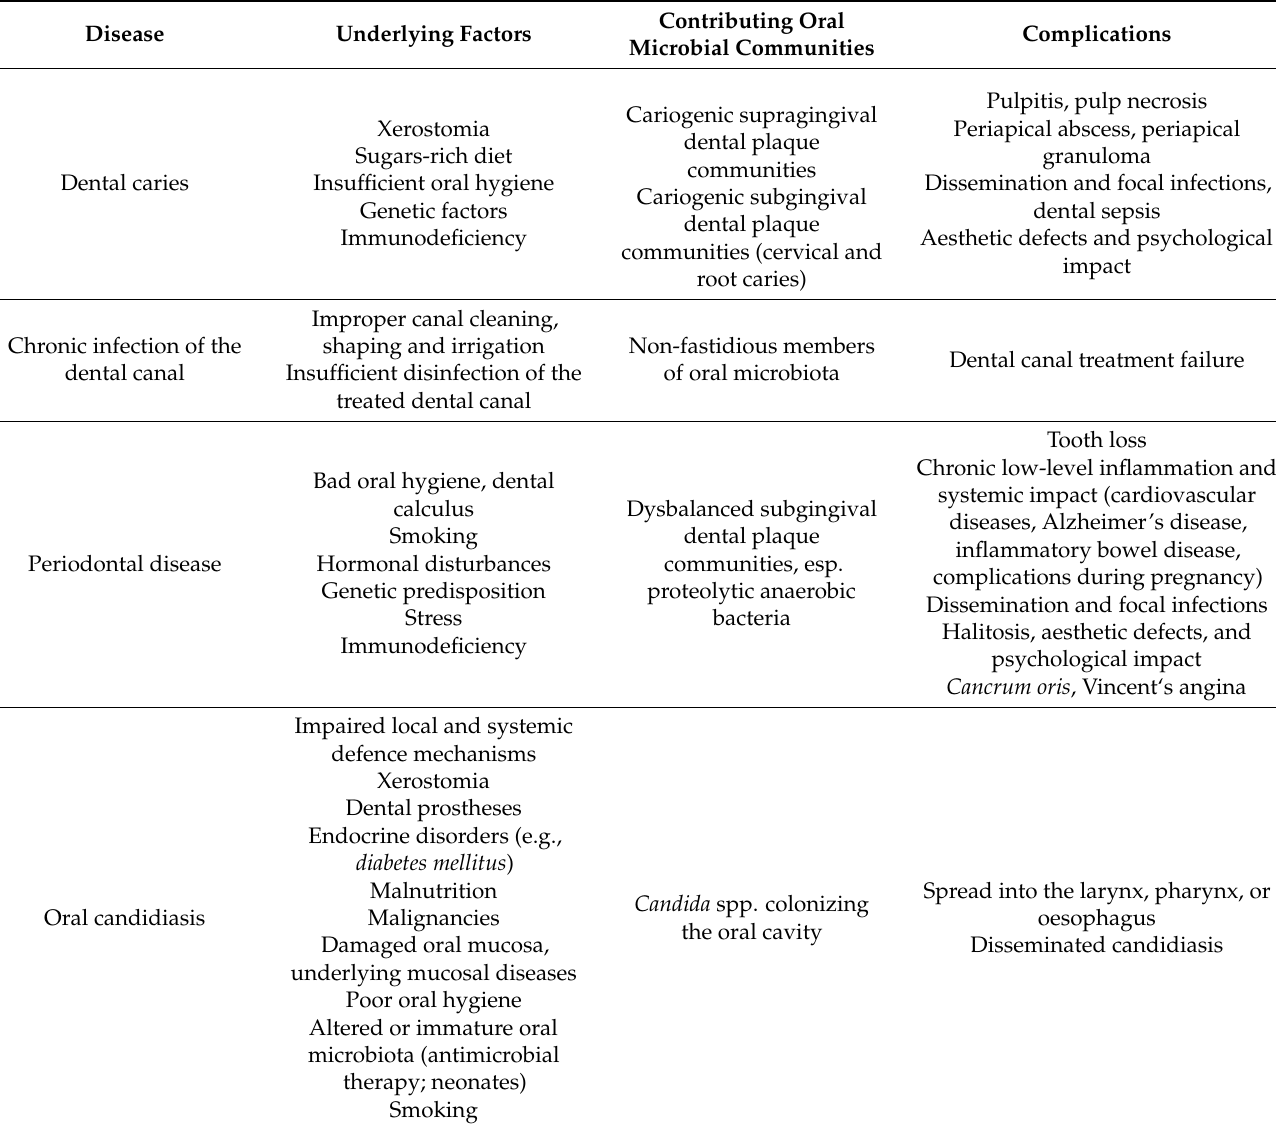
Table 1. The most common oral diseases caused by oral microbiota communities